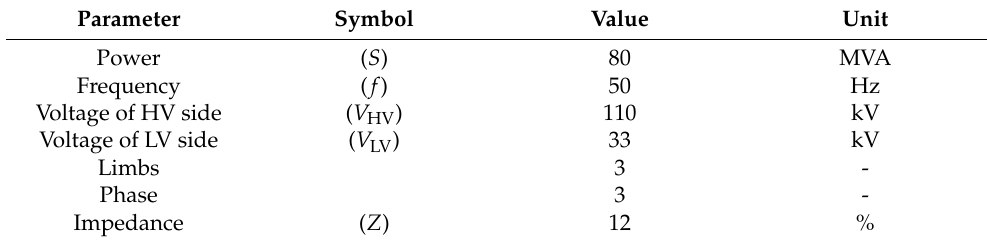
Table 2. The power transformer specifications.